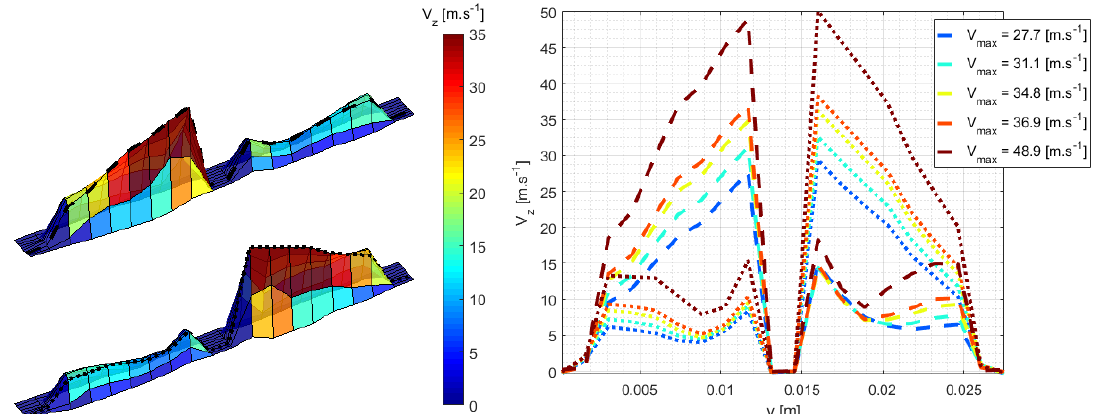
Figure 9. Determination of the peak velocity from the surface interpolation of the velocity field at the nozzle exits. The left figure displays velocity profiles at the peak velocity time instant in the right and the left outlet nozzles of the SaOB actuator, respectively. The dashed and dotted black lines show a spanwise cut through the maximum velocity location. The graph on the right displays velocity profiles at the peak velocities of (approximately) 28 m/s, 31 m/s, 35 m/s, 37 m/s, and 49 m/s (colors are according to line legend). The dashed lines represent velocity peaks at the left nozzle, dotted lines are the right nozzle